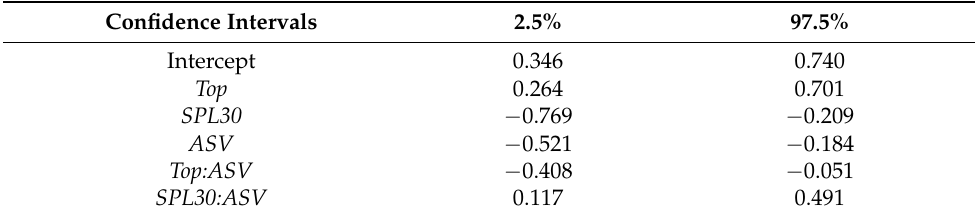
Table 7. Confidence intervals for the independent variables (standardized) with significant effect on TSV . Confidence